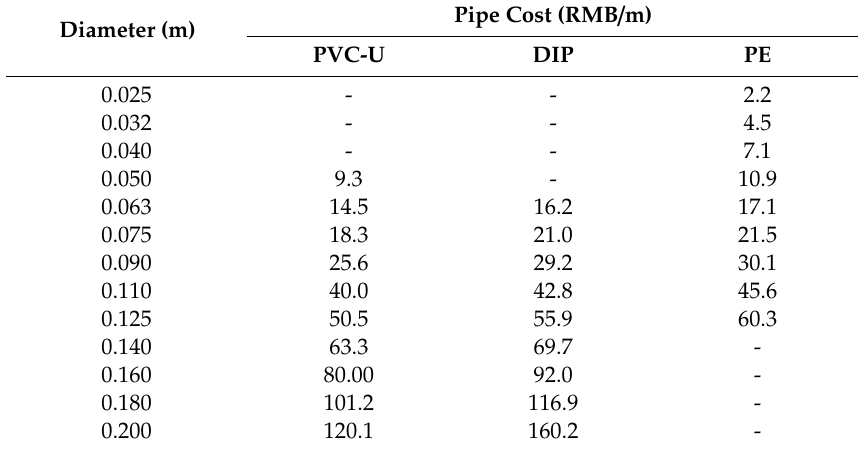
Table 1. Available commercial pipe diameters and corresponding unit costs.